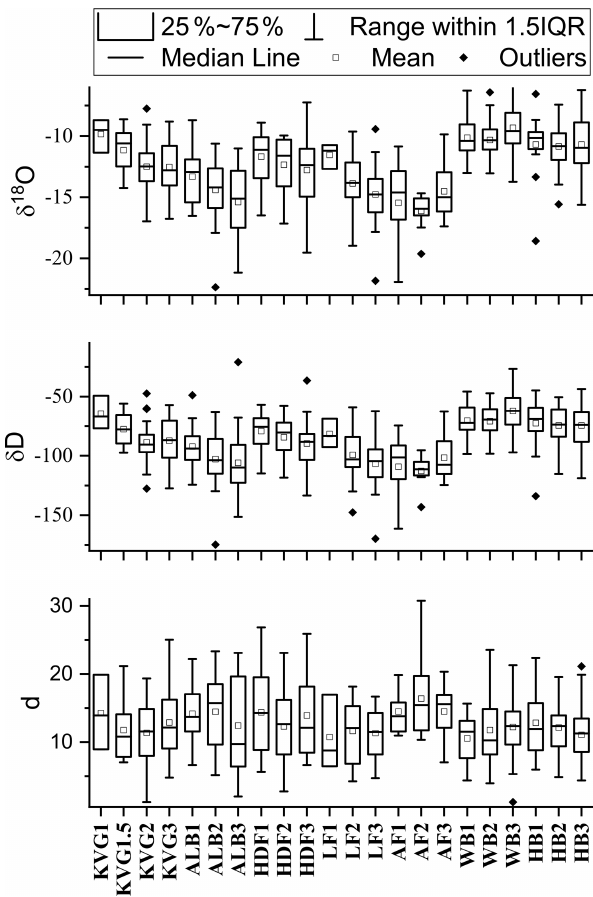
Figure 4. Box plots of stable water isotopes ( δ 18 O and δ 2 H) and deuterium excess ( d ) for each snowpit.